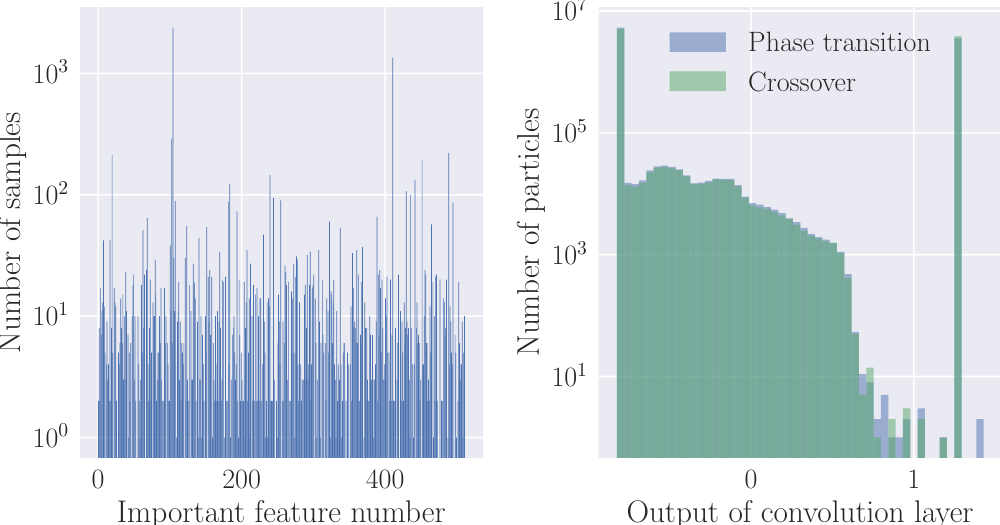
Figure 6 . Left: distribution of the feature number of the most important feature for 10000 pairs of events. An important feature is the global feature which has the largest difference in their values for the two classes. Out of the 512 global features, feature number 104 and 410 heave the highest frequency, they are the most important feature for about 24% and 14% pairs of samples respectively. Right: the output of the convolution layer for the global feature 104. The plot is generated from about 350 samples for each class whose important feature index is